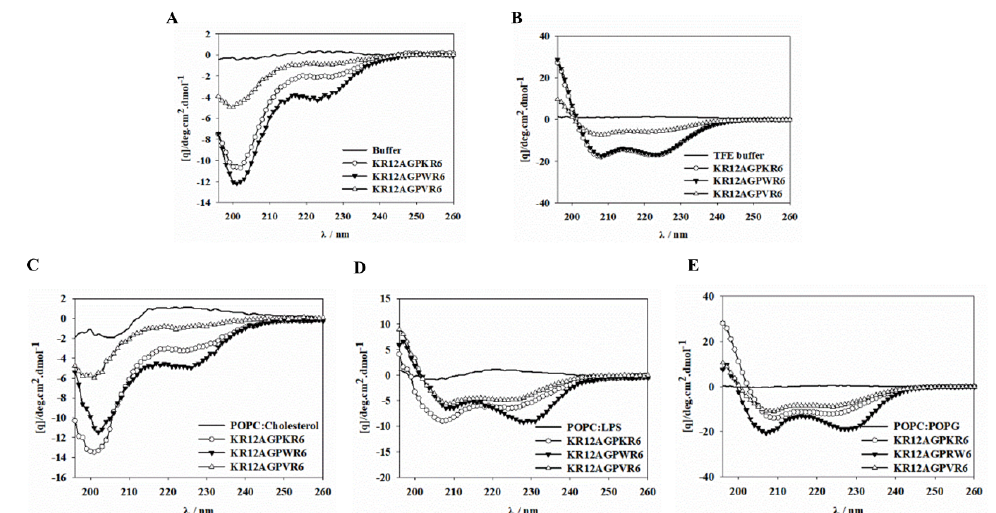
Figure 8. Circular dichroism spectra of the designed peptides. CD spectra were recorded at 60 μ M concentration of KR12AGPKR6, KR12AGPWR6 and KR12AGPVR6 in ( A ) 20 mM phosphate buffer, ( B ) 30% TFE buffer, ( C ) 1 mM POPC/cholesterol, ( D ) 1 mM POPC/LPS and ( E ) 1 mM POPC/POPG LUVs at pH7.4, 25 °C.